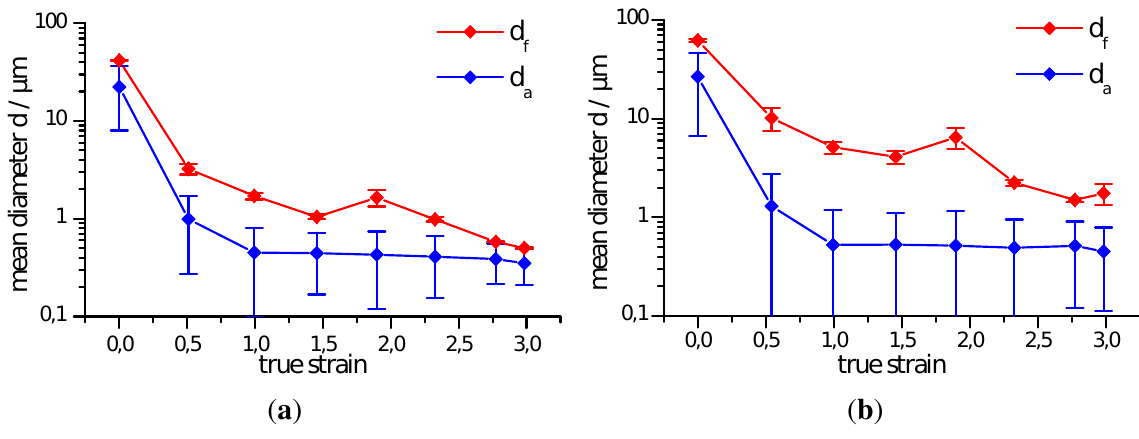
Figure 4. Development of mean diameter using different calculation methods: arithmetic average (blue); area weighted average (red). ( a ) angle to define grain boundary: ≥ 3 ◦ ; ( b ) angle to define grain boundary: ≥ 15 ◦